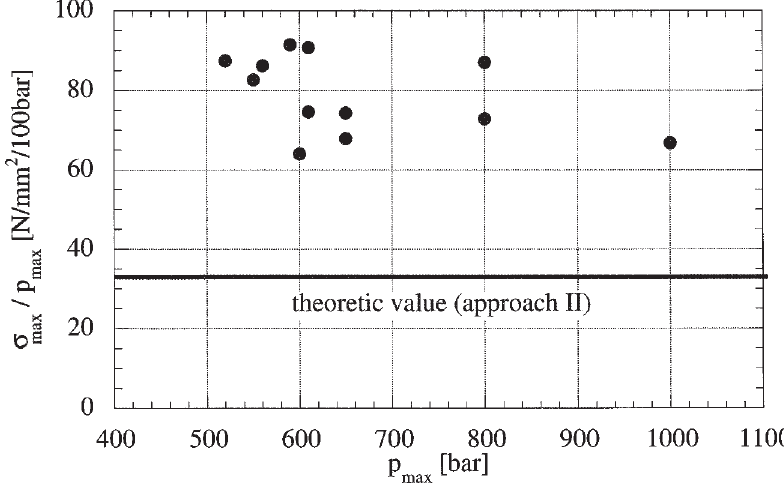
Fig. 15. Comparison between measured and theoretical values of the tangential stresses. The tangential stresses obtained in different experiments at different initial acetylene pressures were scaled by dividing through the respective detonation pressure p max , which was expressed in multiples of 100